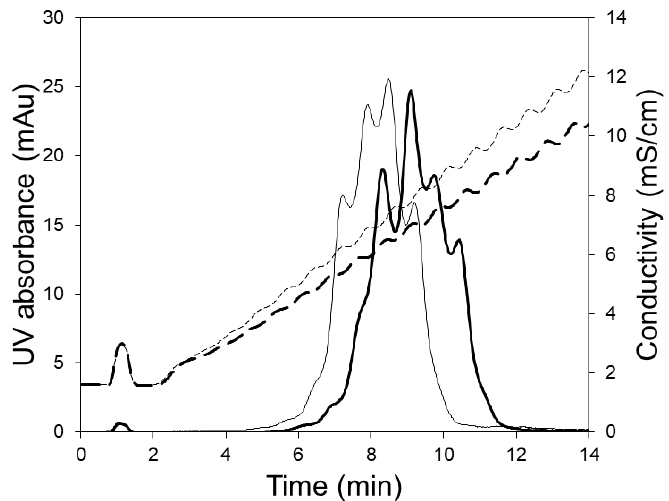
Figure 6. HIgG1-CD4 charge variant separation with HiTrap SP HP column using 250 mL (thin line) and 300 mL (thick line) linear salt gradients (column volume: 5.0 mL; feed: 0.5 mg/mL hIgG1-CD4; sample volume: 2 mL; binding buffer: 20 mM sodium phosphate pH 6.0; eluting buffer: binding buffer + 0.5 M NaCl; flow rate: 15 mL/min, solid line: UV absorbance; dashed line: conductivity).